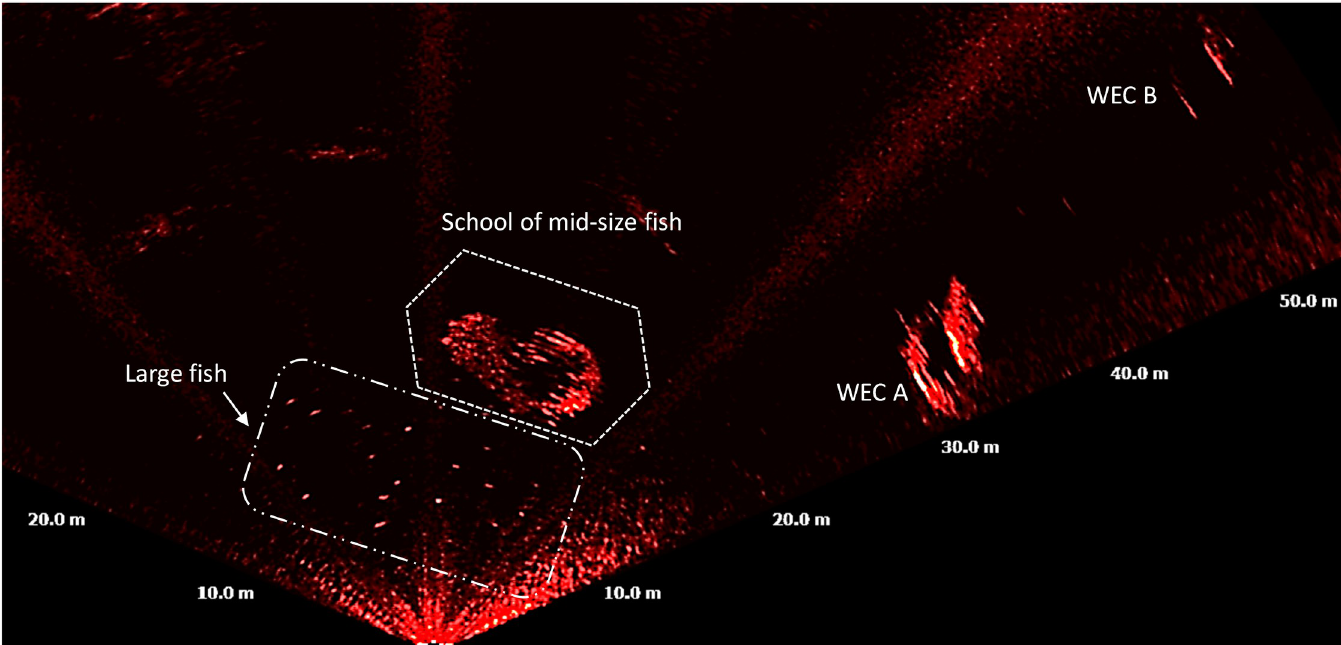
Fig 10. Acoustic image acquired on 26/08/16 at 19:26 UTC, showing a school mid-size fish and at least 20 large size fish. The school measured 12 m of diagonal length and the individual large fish measured between 0.4 m and 0.9 m.